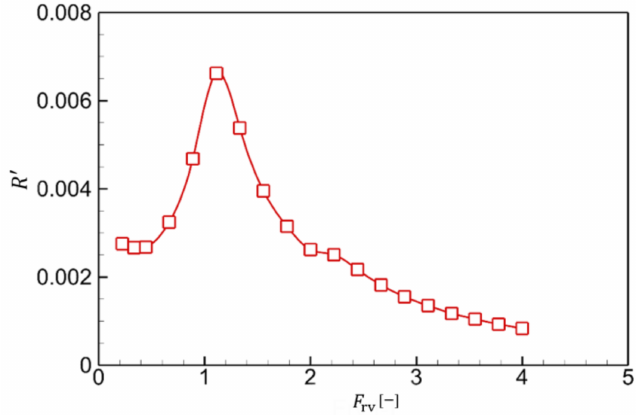
Figure 4. Resistance of the USV in direct